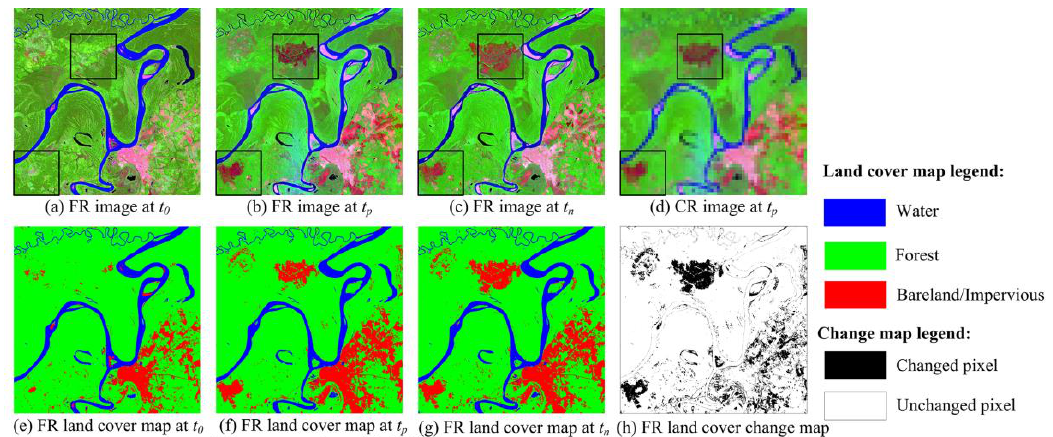
Figure 4. The FR images, CR image, FR land cover maps and FR land cover change map used in the experiment for the forest fire experiment. The scale factor s was 16. ( a ) FR image at t 0 from Landsat image acquired on 7 June 2010; ( b ) FR image at t p from Landsat image acquired on 11 September 2010; ( c ) FR image at t n from Landsat image acquired on 27 September 2010; ( d ) CR image at t p resampled from ( b ); ( e ) FR land cover map at t 0 ; ( f ) FR land cover map at t p (reference land cover map); ( g ) FR image at t n ; ( h ) FR land cover change map that was produced by comparing ( e – g ).